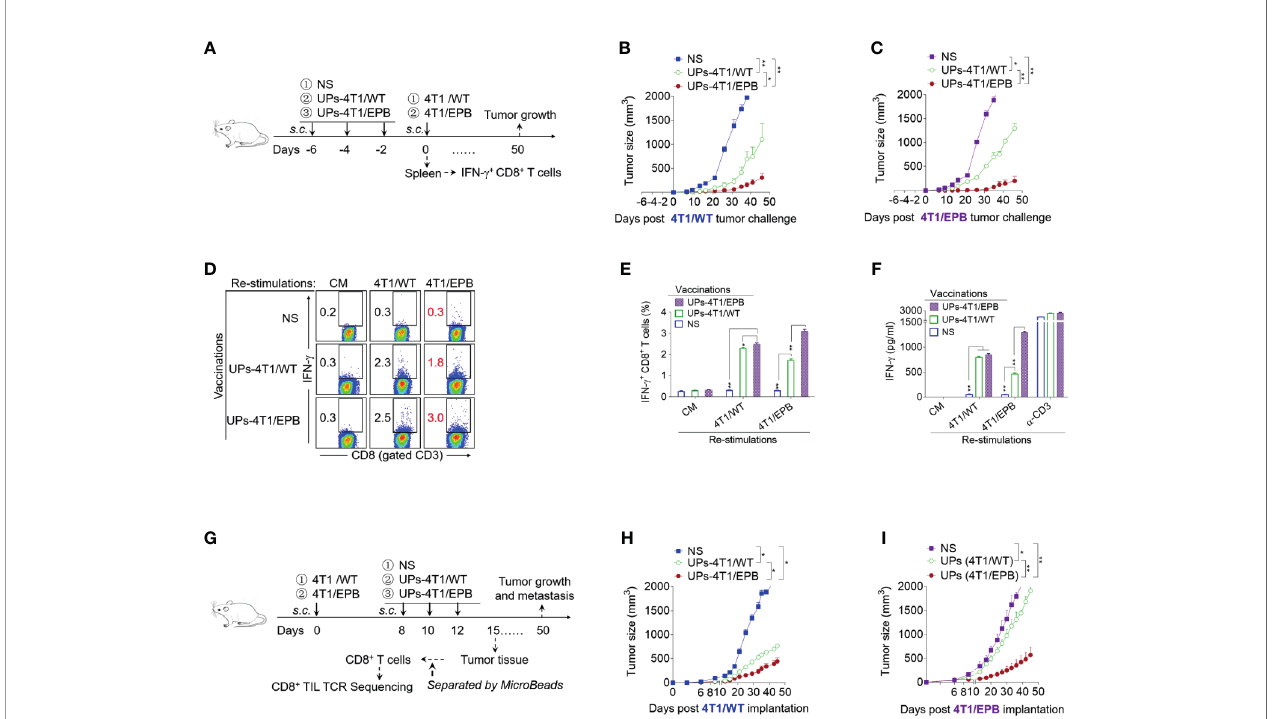
FIGURE 2 | Ubiquitinated proteins (UPs)-4T1/epirubicin (EPB) nanovaccine induced strong anti-tumor effects in 4T1/WT and 4T1/EPB tumor-bearing mice. (A) The immunization protocol of UP vaccination for the prophylactic treatment. BALB/c mice received a s.c. injection of NS, UPs-4T1/WT nanovaccine, or UPs-4T1/EPB nanovaccine three times at 2-day intervals. Two experiments were performed concomitantly, one in which the mice ( n = 7 per group) received tumor challenge with 5 × 10 5 4T1/WT cells or 4T1/EPB cells 2 days after the last immunization and one in which splenocytes were harvested after the mice ( n = 5 per group) were sacri fi ced for further experiment at 1 week after the last immunization. (B, C) Tumor growth was monitored after 4T1/WT (B) or 4T1/EPB (C) challenge. (D – F) The splenocytes collected from (A) were then stimulated with inactivated 4T1/WT cells or 4T1/EPB cells for 24 h, and the IFN- g + CD3 + CD8 + T cells were examined by fl ow cytometry (D, E) . The supernatants were collected and examined for IFN- g with an ELISA assay (F) . (G) Schematic diagram of UP vaccination for the therapeutic treatment. A total of 5 × 10 5 4T1/WT cells or 4T1/EPB cells were respectively injected into BALB/c mice on day 0. Tumor-bearing mice received a s.c. injection of NS, UPs-4T1/WT nanovaccine, or UPs-4T1/EPB nanovaccine three times on days 8, 10, and 12 ( n = 12 per group). Six mice were used for observations of tumor growth and survival until day 50. On day 15, six mice from each group in 4T1/EPB tumor-bearing mice were sacri fi ced, and the tumor tissues were separated for CD8 + TIL isolation. (H, I) Tumor growth was monitored in 4T1/WT (H) or 4T1/EPB (I) tumor-bearing mice. P -values were determined by Mann – Whitney U -test. The results are representative of three independent experiments, and data were expressed as means ± SEM (* p < 0.05; ** p < 0.01; ns, not signi fi